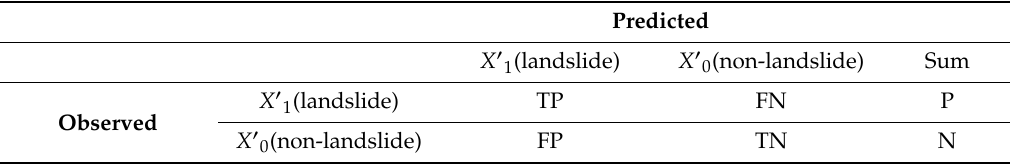
Table 2. Technical attributes of the confusion